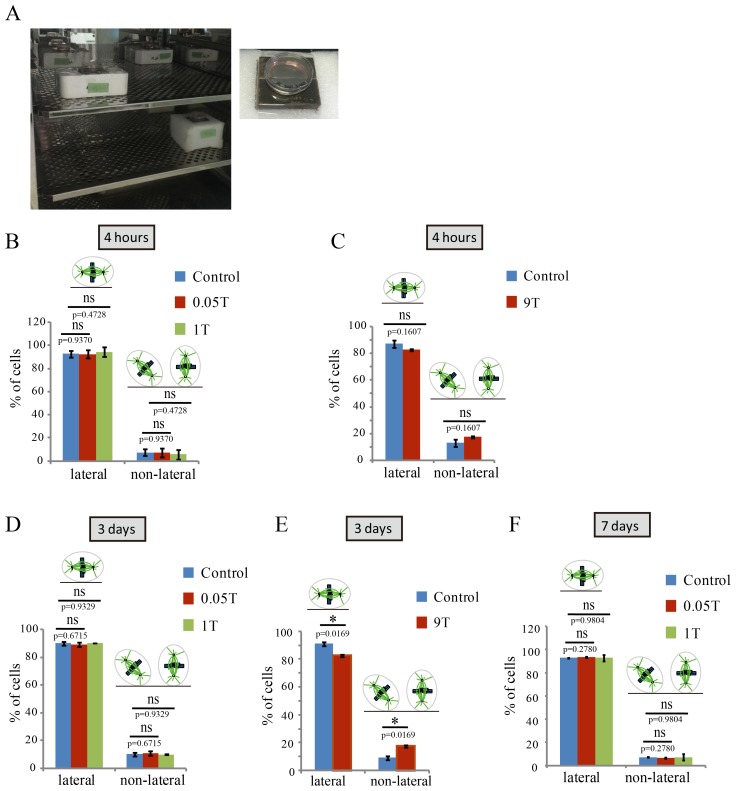
SMFs affected spindle orientation in a field intensity dependent manner.CNE-2Z cells were plated on coverslips in the 35 mm or 24 well tissue culture plate one night ahead to allow the cells to attach. On the day of experiment, they were exposed to different intensity SMFs for different time before they were taken out, fixed and stained with anti-tubulin antibody (for microtubules) and DAPI (for DNA). (A) 0.05 T and 1 T moderate intensity SMF exposure experimental set-up. Permanent magnets were placed inside a regular full-sized cell incubator to ensure proper culture conditions. Cell culture plate was placed on the top surface center of the magnet. (B–F) Quantification of spindle orientations in control, 0.05 T, 1 T or 9 T treated cells. Total of 200–300 metaphase spindles from 3–4 independent coverslips were examined for each condition. Data is presented as mean ± SD. ‘ns’, not significant; *p<0.05.DOI:
http://dx.doi.org/10.7554/eLife.22911.01110.7554/eLife.22911.012Figure 4—source data 1.Quantification of spindle orientations in control, 0.05 T or 1 T treated cells (4 hr treatment).This is the source data for Figure 4B.DOI:
http://dx.doi.org/10.7554/eLife.22911.01210.7554/eLife.22911.013Figure 4—source data 2.Quantification of spindle orientations in control, or 9 T treated cells (4 hr treatment).This is the source data for Figure 4C.DOI:
http://dx.doi.org/10.7554/eLife.22911.01310.7554/eLife.22911.014Figure 4—source data 3.Quantification of spindle orientations in control, 0.05 T or 1 T treated cells (3d treatment).This is the source data for Figure 4D.DOI:
http://dx.doi.org/10.7554/eLife.22911.01410.7554/eLife.22911.015Figure 4—source data 4.Quantification of spindle orientations in control, or 9 T treated cells (3d treatment).This is the source data for Figure 4E.DOI:
http://dx.doi.org/10.7554/eLife.22911.01510.7554/eLife.22911.016Figure 4—source data 5.Quantification of spindle orientations in control, 0.05 T or 1 T treated cells (7d treatment).This is the source data for Figure 4F.